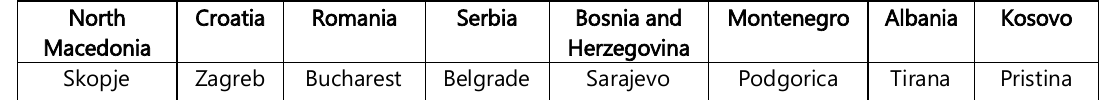
Table 1: TIKA Program Coordination Offices in the Balkans (Source: Türk İş birli ğ i ve Koordinasyon Ajansı Ba ş kanlı ğ ı 2022)